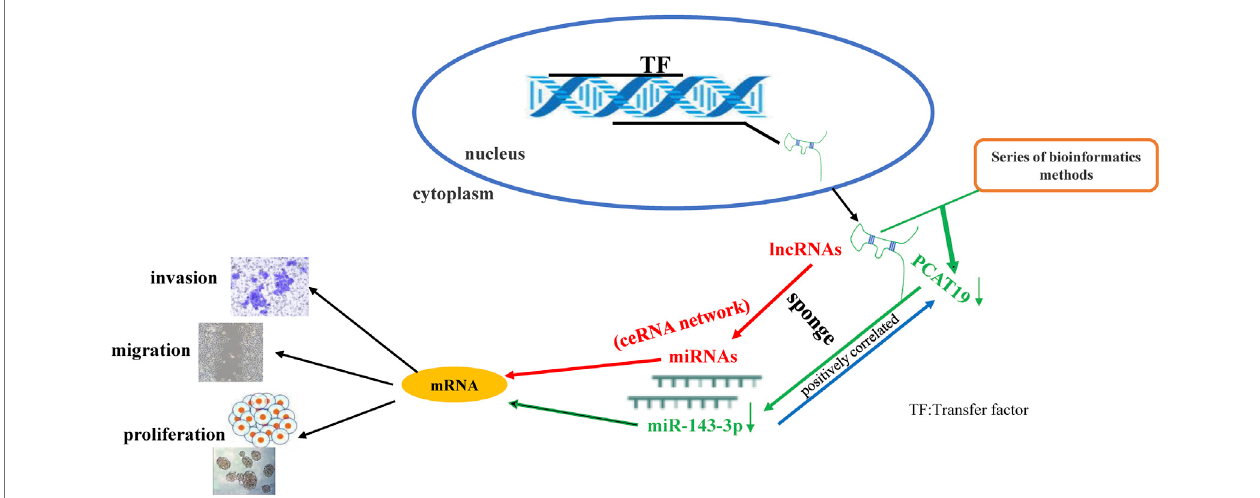
GRAPHICAL ABSTRACT | Our data revealed that PCAT19 regulates the proliferation, migration, and invasion of lung cancer cells by targeting the miR-301b-3p. Thered arrow,red line,and redfontindicatethattheprogressionoflungcancercellscanberegulatedthroughanlncRNA/miRNA/mRNAregulatorynetwork.Thegreen arrow, greenline,and greenfontrepresent thePCAT19/miR-143-3p/mRNAregulatorynetworkwescreenedandanalyzed inthisproject.Blackarrows, blacklines,and black fonts represent the common regulation process of the two situations in the fi gure. TF, transfer